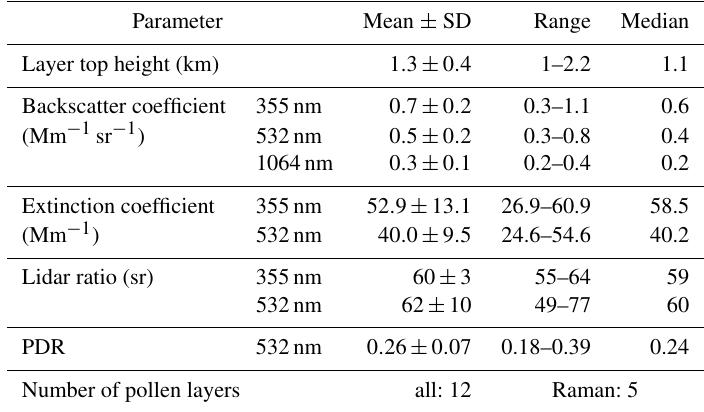
Table 2. Mean values, range and median of optical properties of the detected pollen layers in the second measurement period: 12–15 May, spruce-contaminated